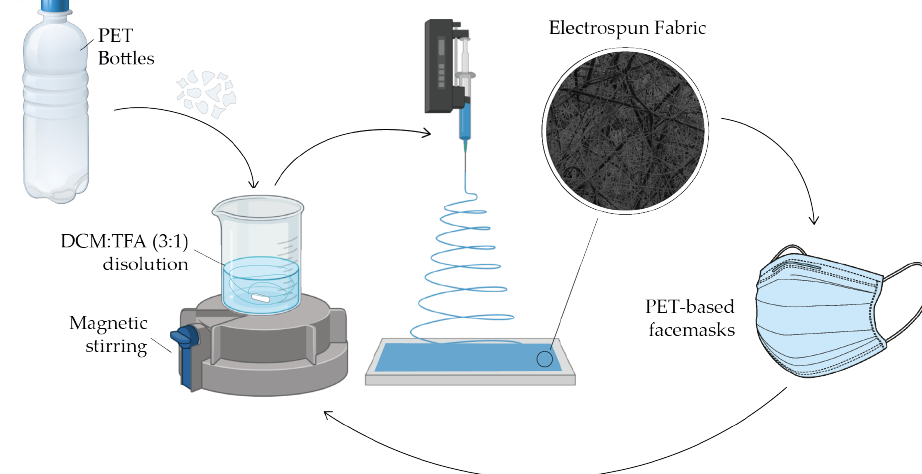
Figure 1. Schematic representation of the PET-based face mask